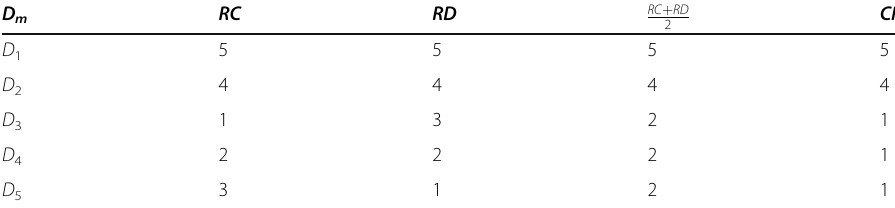
Table 9 A composite rank measure produced by averaging RC and RD D m RC RD RC þ RD